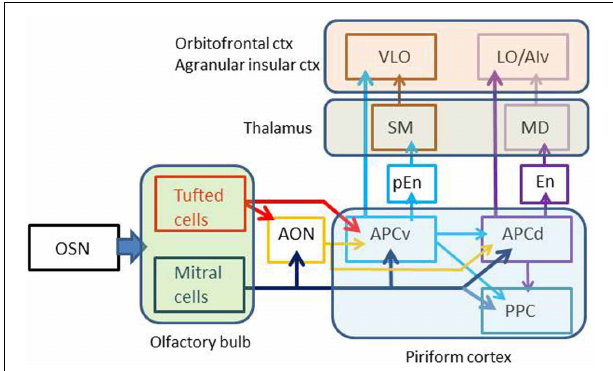
FIGURE 2 | Multiple parallel pathways from the olfactory sensory neurons to the orbitofrontal cortex. Arrows indicate axonal projection. AON, anterior olfactory nucleus; APCv, ventral part of the anterior piriform cortex; APCd, dorsal part of the anterior piriform cortex; PPC, posterior piriform cortex; pEn pre-endopiriform nucleus; En, endopiriform nucleus; SM, submedius nucleus of thalamus; MD, mediodorsal nucleus of thalamus; OSN, olfactory sensory neuron; VLO, ventrolateral orbital cortex; LO, lateral orbital cortex; AIv, ventral agranular insular cortex. Olfactory bulb gives rise to parallel tufted and mitral cell pathways to the olfactory cortex. APCv sends odor information directly to the VLO or indirectly via the pEn and SM, while APCd transfers odor information directly to the LO/AIv or indirectly via the En and